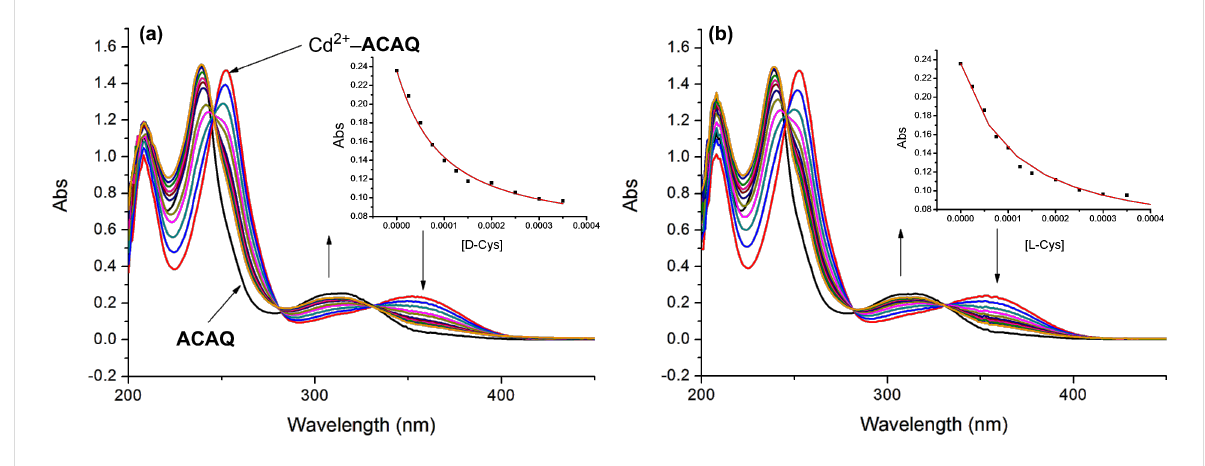
Figure 8: UV spectra of Cd 2+ – ACAQ (25 µm) upon the titration of (a) D-Cys, (b) L-Cys (0–12 equiv) in buffer solution (10 mM , HEPES, 50% ACN, pH 7.4 ) at 298 K. The inset shows the titration data points and the nonlinear least-squares fitting curve.